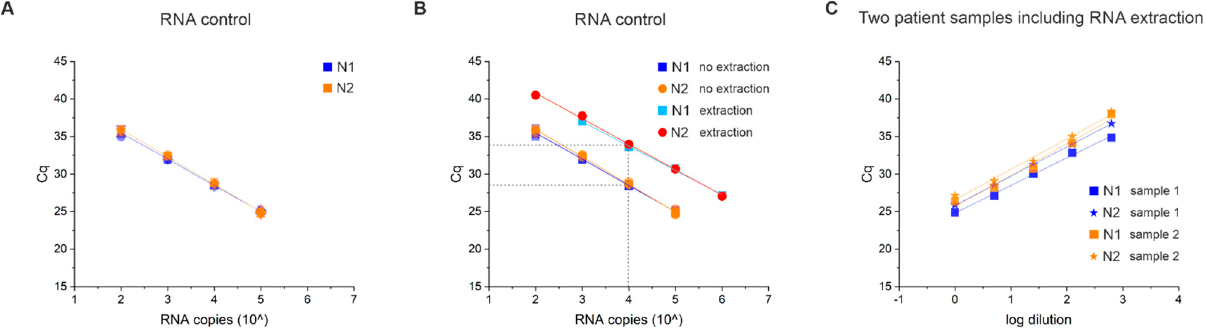
Figure 4. Technical sensitivity, reproducibility, and efficiency of our assay. ( A ) SARS-CoV-2 RNA control was diluted in several fold dilution steps (10 5 , 10 4 , 10 3 , and 10 2 copies) and measured with RT-qPCR in four or eight replicates (different symbols characterize the different replicates) using the virus specific N1 (blue) and N2 (orange) primer/probe sets. Cq values were plotted against viral synthetic RNA copies. ( B ) SARS-CoV-2 RNA control was added to a pool of negative patient samples to have 10 6 , 10 5 , 10 4 , 10 3 , and 10 2 RNA copies/reaction before the RNA extraction step followed by RT-qPCR. Cq values for N1 (light blue, including RNA extraction) and N2 (red, including RNA extraction) were monitored and plotted against the increasing number of RNA copies used. The Cq values are compared with the measurements of RNA copies that have been measured without including an RNA extraction step (see plot ( A ); N1, blue; N2, orange). The dotted line visualizes the difference in Cq values of detecting the same number of RNA molecules (e.g., 10 4 copies) that are either present before (N1 and N2, no extraction) or after (N1 and N2, extraction) RNA extraction. ( C ) Two positive patient samples collected in COBAS lysis buffer were diluted in a series of 1:5 (1:1, 1:5, 1:25, 1:125, 1:625) using buffer 6 before extracting viral RNA followed by RT-qPCR. Detected Cq values for N1 (square) and N2 (asterisk) of both samples (sample 1, blue; sample 2, orange) were plotted against the dilution factor in a log scale. For all plots, the linear correlation (R 2 ) was higher than 0.98.